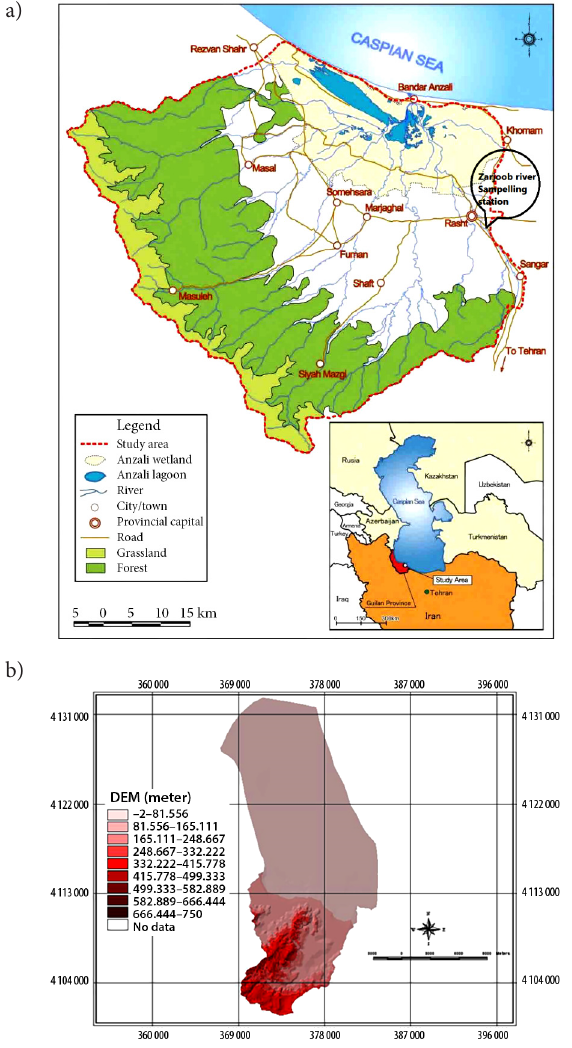
Figure 1. a) Location map of Anzali Lagoon and Zarjoob River with stormwater station; b) Digital elevation model (DEM-GIS) of Zarjoob